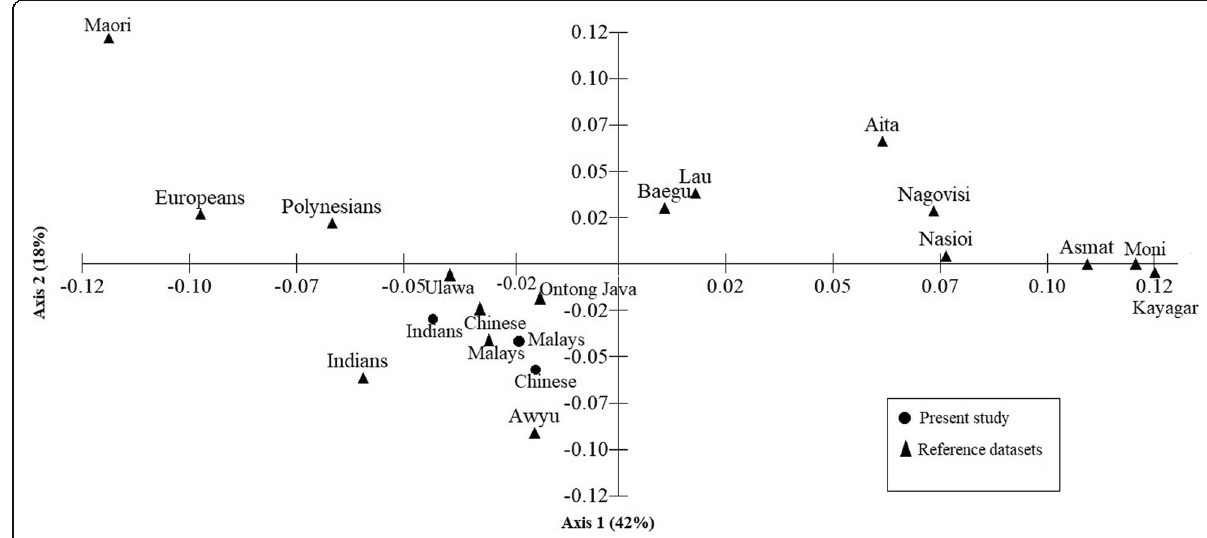
Fig. 1 Principal component plot constructed using ABO, Rhesus, and MNS blood group frequency